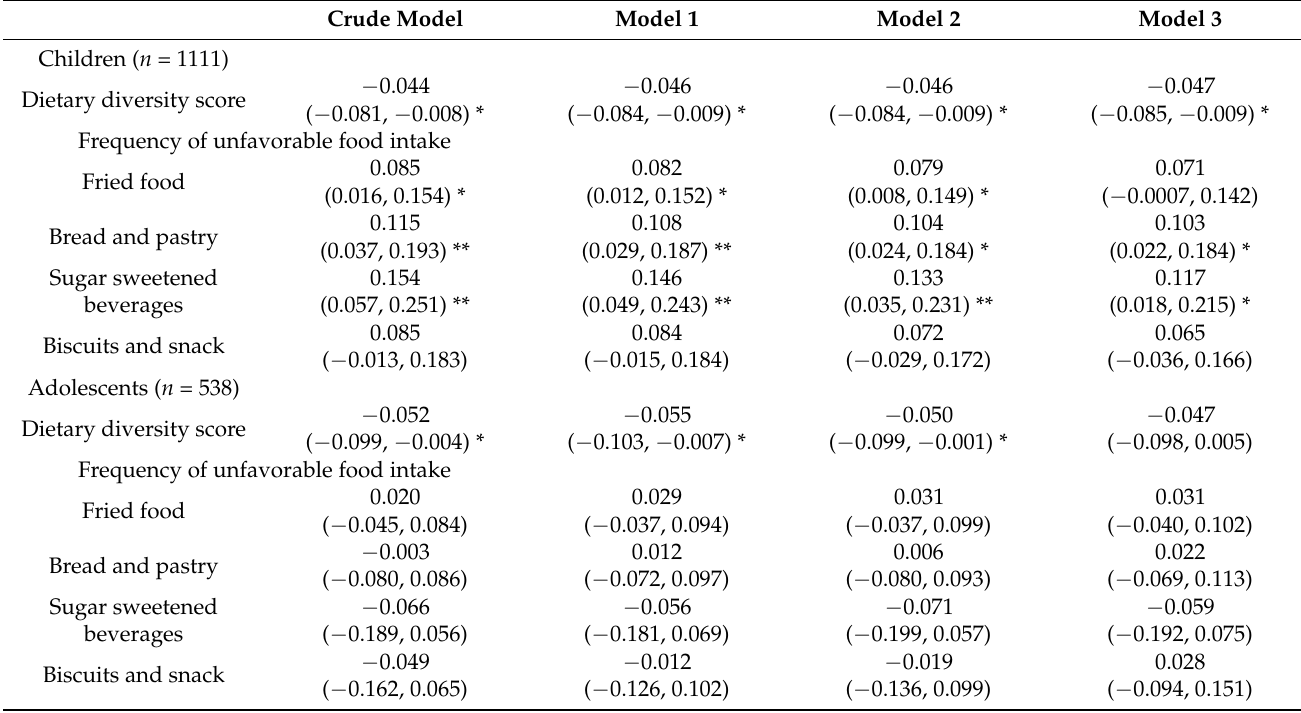
Table 2. β coefficients (95% confidence interval) of association between food security status and dietary quality score, unfavorable food intake by multiple linear regression.